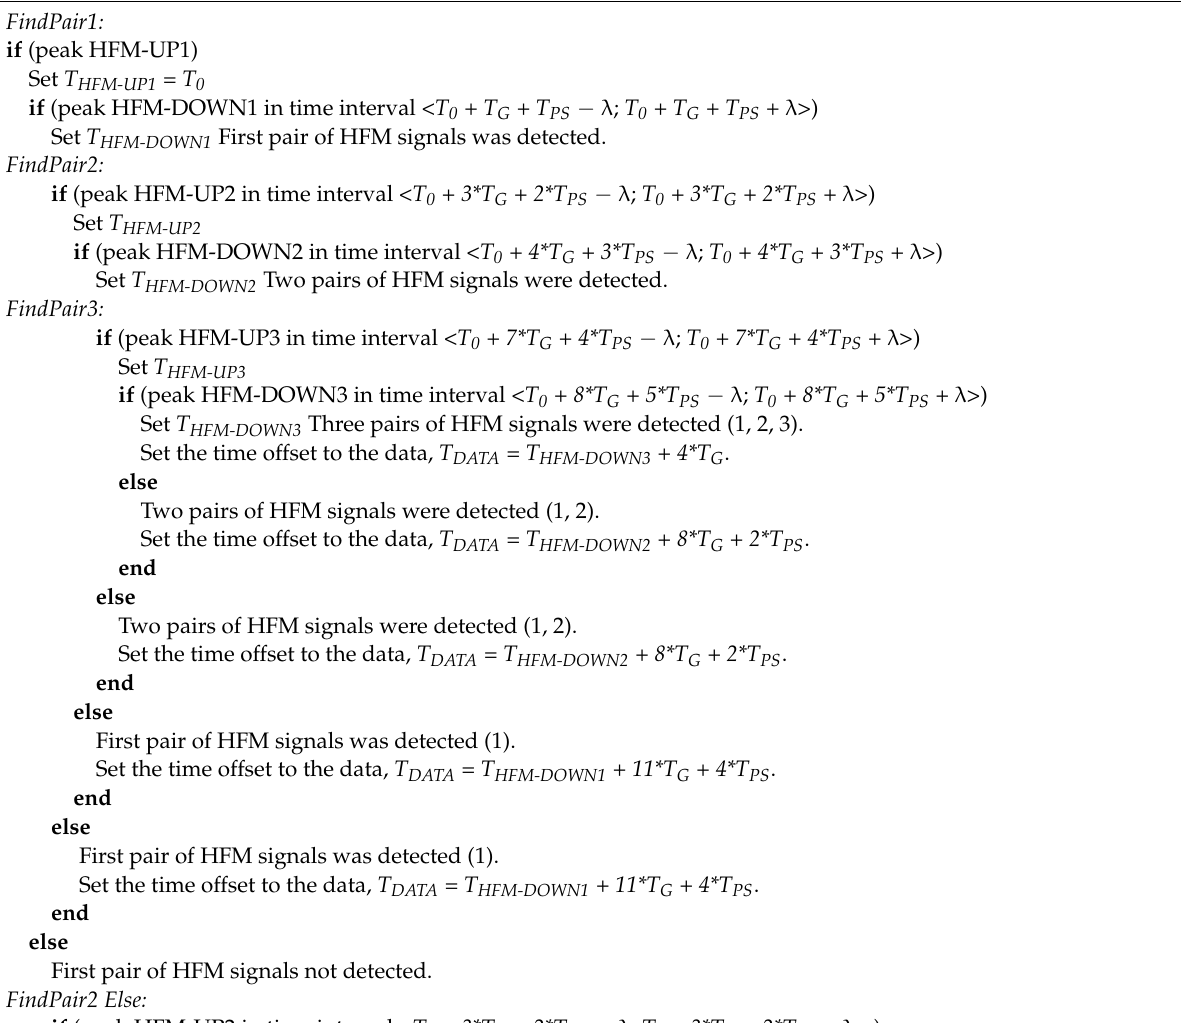
Algorithm 1. Determination of pairs of HFM signals in a data